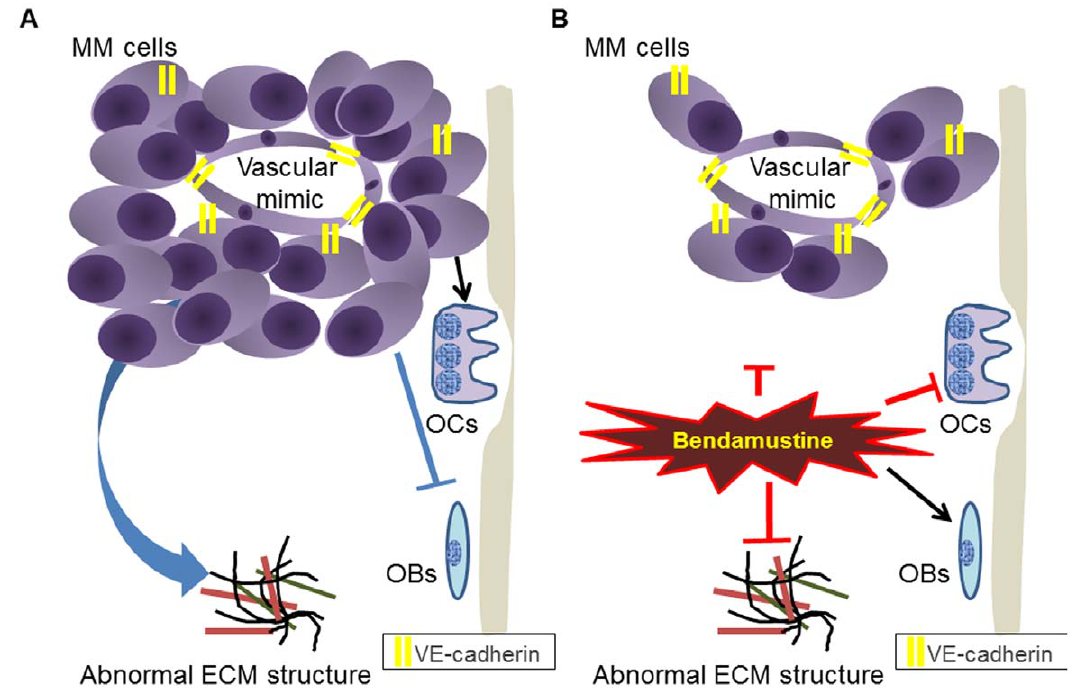
Figure 9. Anti-MM effects of bendamustine on MM cells and the BM niche. MM interacts with several BM microenvironments ( A ). Within the MM BM niche, bendamustine affects both MM cells and the surrounding niche in vivo ( B ). OBs, osteoblast cells; OCs, osteoclast